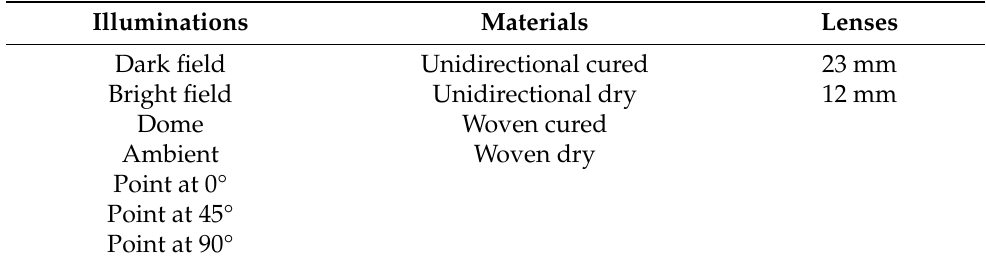
Table 2. Lists of illumination conditions, material types and lenses considered in this paper. N.B. Multiple illuminations/lenses are used for each